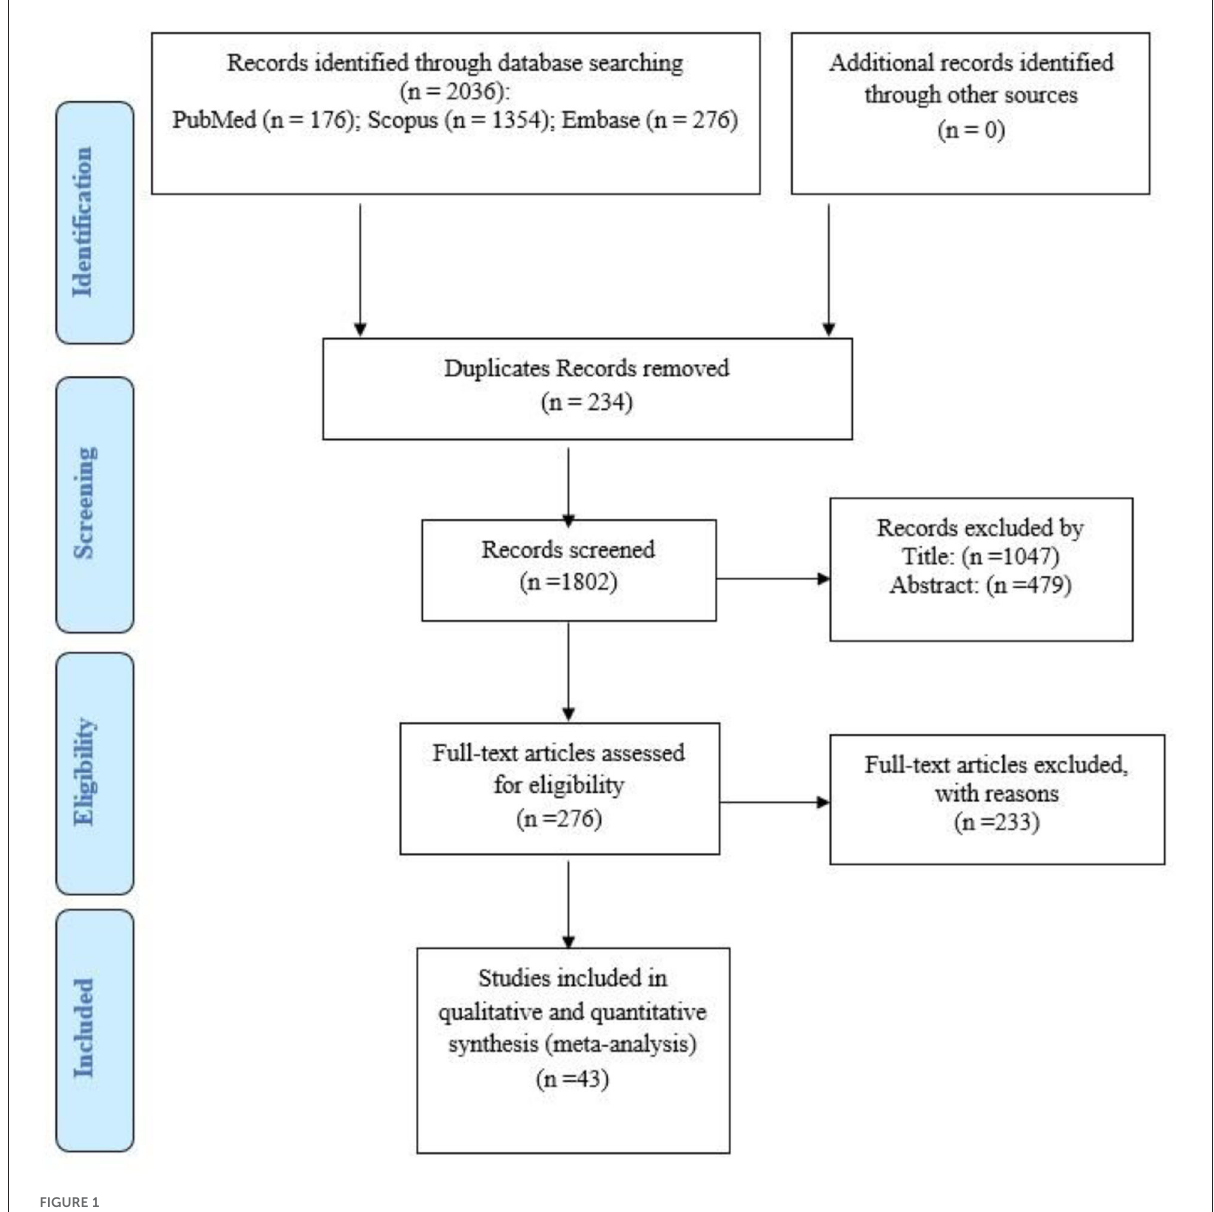
FIGURE1 Flowchart of systematic review and